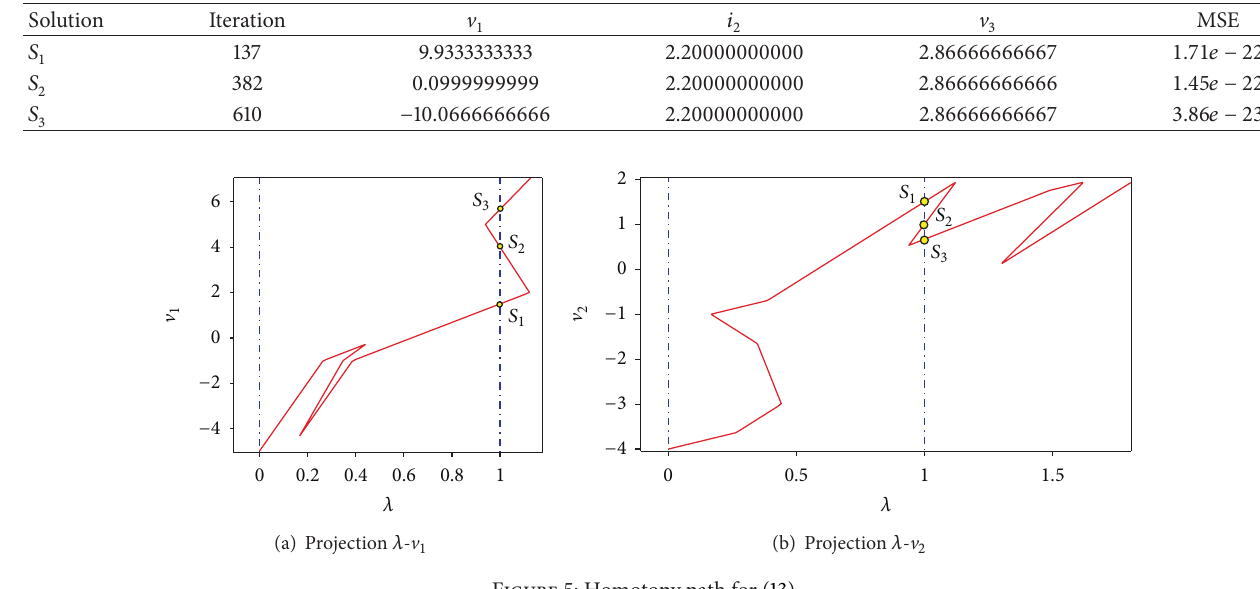
Figure 5: Homotopy path for (13).